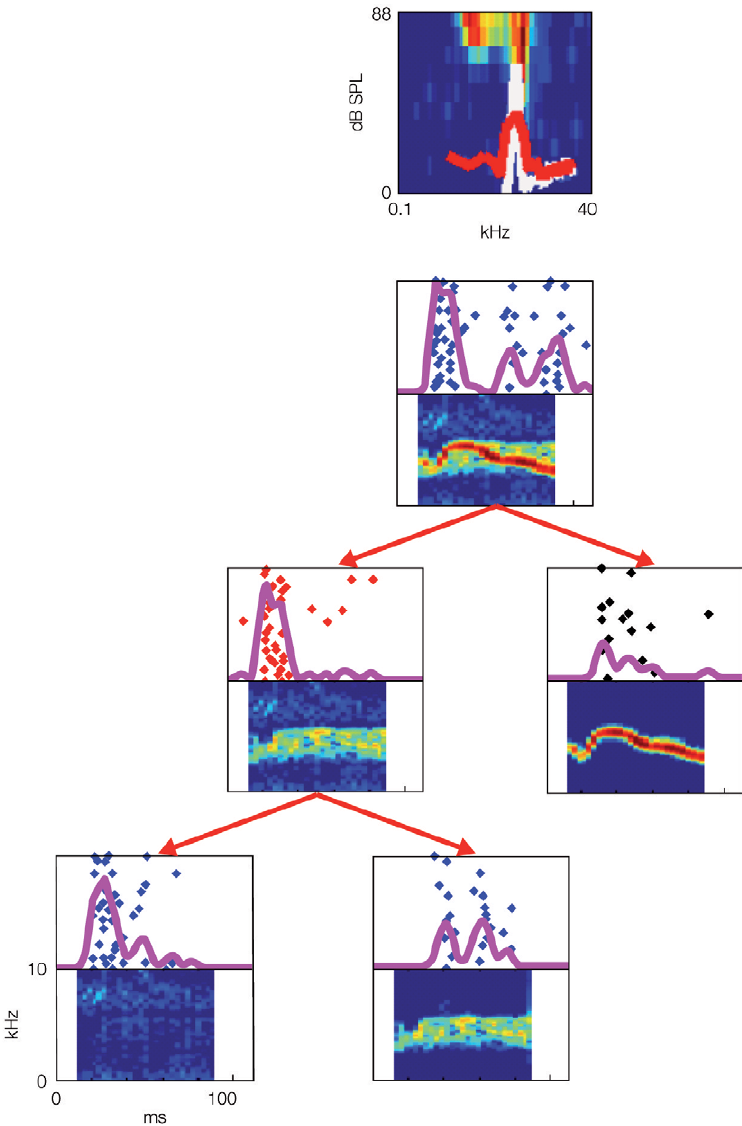
Figure 2 | The frequency response area of a neuron in cat primary auditory cortex (top) and its responses to a natural chirp and some of its modifi ed versions. Further details in the